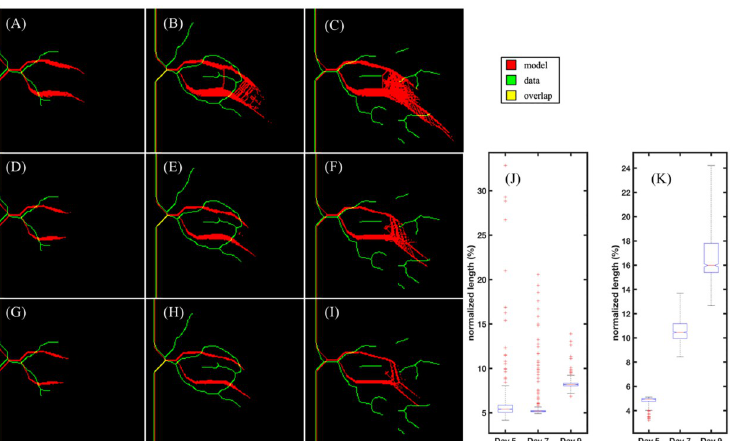
Fig 9. Local region 1: Prediction. Each column depicts the data (green), model prediction (red), and overlap of the two (yellow) on days 5, 7, and 9, respectively. Each row shows the predicted centerlines using three different thresholds: 99% prediction (Fig 9A-C: top row), 95% prediction (Fig 9D-F: middle row), and 90% prediction (Fig 9G-H: bottom row) of the simulations. While the data exhibits vessel anastomosis at Day 7, the model prediction only depicts anastomosis in the 1% prediction at Day 7 (Fig 9B) and Day 9 (Fig 9C and 9F and 9I). Fig 9J and 9K shows the prediction of the average centerline distance from model to data and from data to model, respectively. The average centerline distance is normalized by the length of the longest sprout in this region at day 3. This results in a normalized length of less than 10% from model to data and a normalized length of less than 20% from data to model. However, at day 9 the complexity in the vascular network, specifically the vascular remodeling that eliminates the anastomosis, is beyond the capabilities of the model to predict. https://doi.org/10.1371/journal.pcbi.1009499.g009 Table 5. Error in the prediction of vessel centerlines. We compare the relative error in the prediction of vessel centerlines calculated from simulations of local vasculature (shown in Fig 9). C dist ( d , m ) is the average centerline distance between the skeletonized vessel in the data, d , and the skeletonized vessel predicted by the model, m . C dist ( m , d )